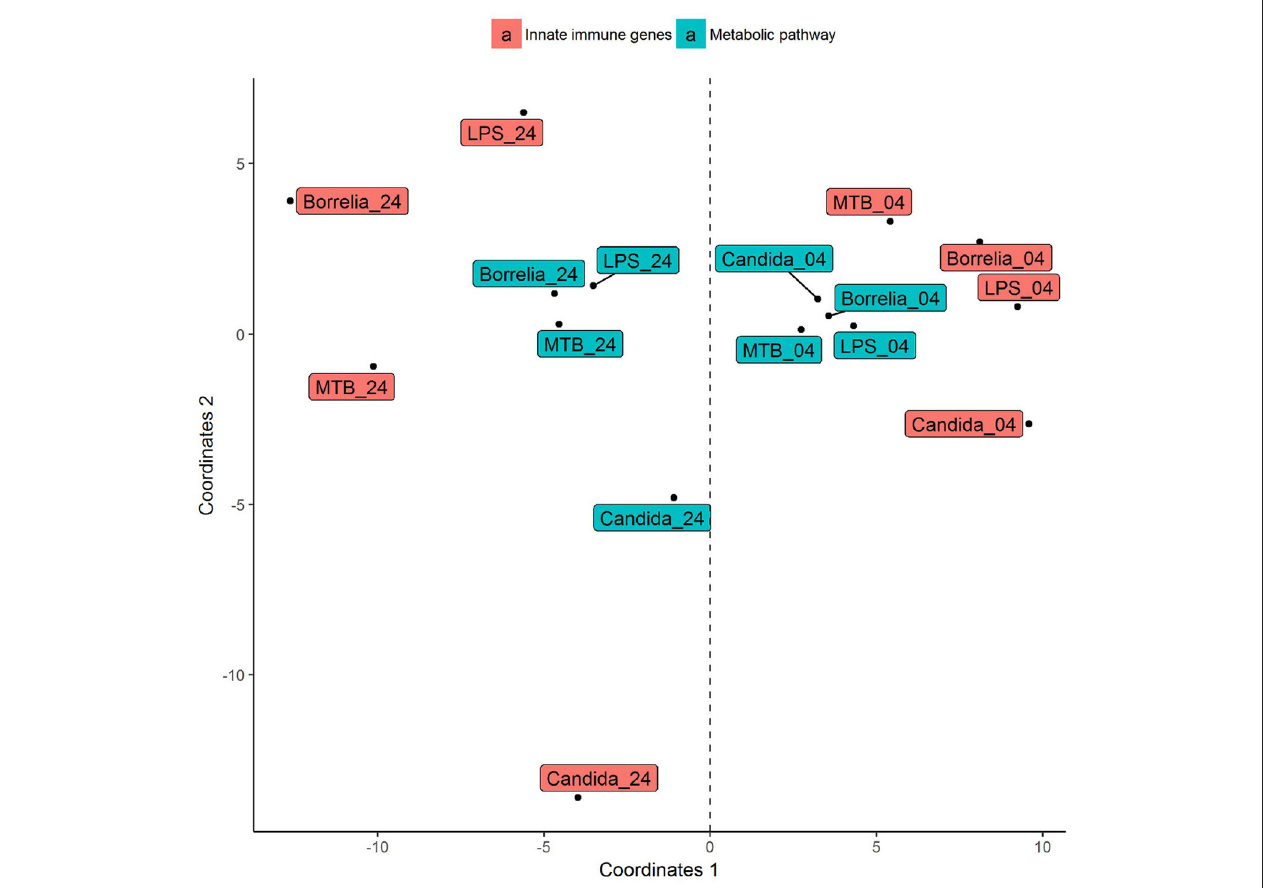
FIGURE 4 | Multidimensional scaling of differential expression patterns of human PBMCs stimulated by Candida , Borrelia , LPS, and MTB at 4 and 24 h. Differential expression patterns were derived from genes involved in KEGG metabolic pathways and innate immunity. Euclidean distance is calculated to quantify similarity between two metabolic pathway gene expression